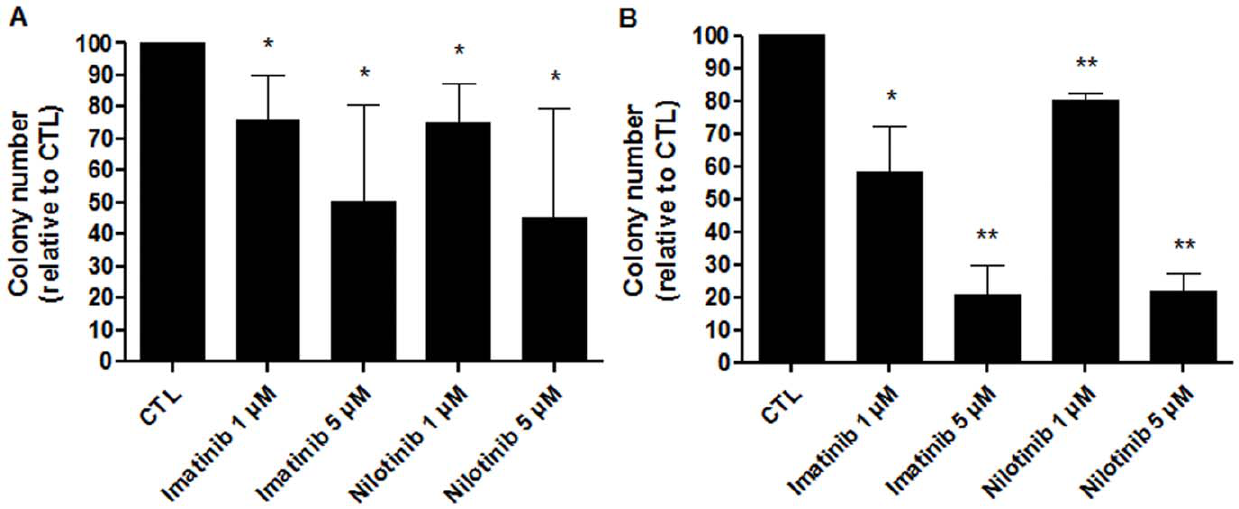
Figure 2. TKIs dramatically decrease CFC formation. ( A ) : Influence of a 48-hour pre-culture in the presence of either imatinib or nilotinib on CFC formation. ( B ) : CFC generation in CFC assays supplemented with TKIs. Results are expressed as mean percentages relative to control experiments without TKIs 6 SD. n=4, *p , 0.05, **p , 0.005 versus CTL, Student’s paired t tests. CTL: control condition without TKIs.